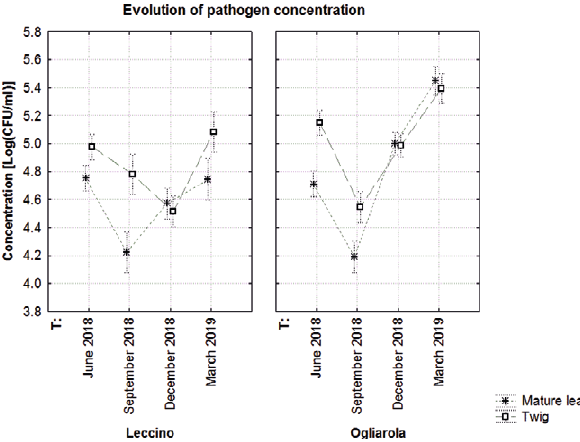
Figure 8. Mean Xylella fastidiosa concentration in diff erent tissues (lower parts of mature leaves with petioles and twigs) of two olive cultivars at diff erent sampling times (T).